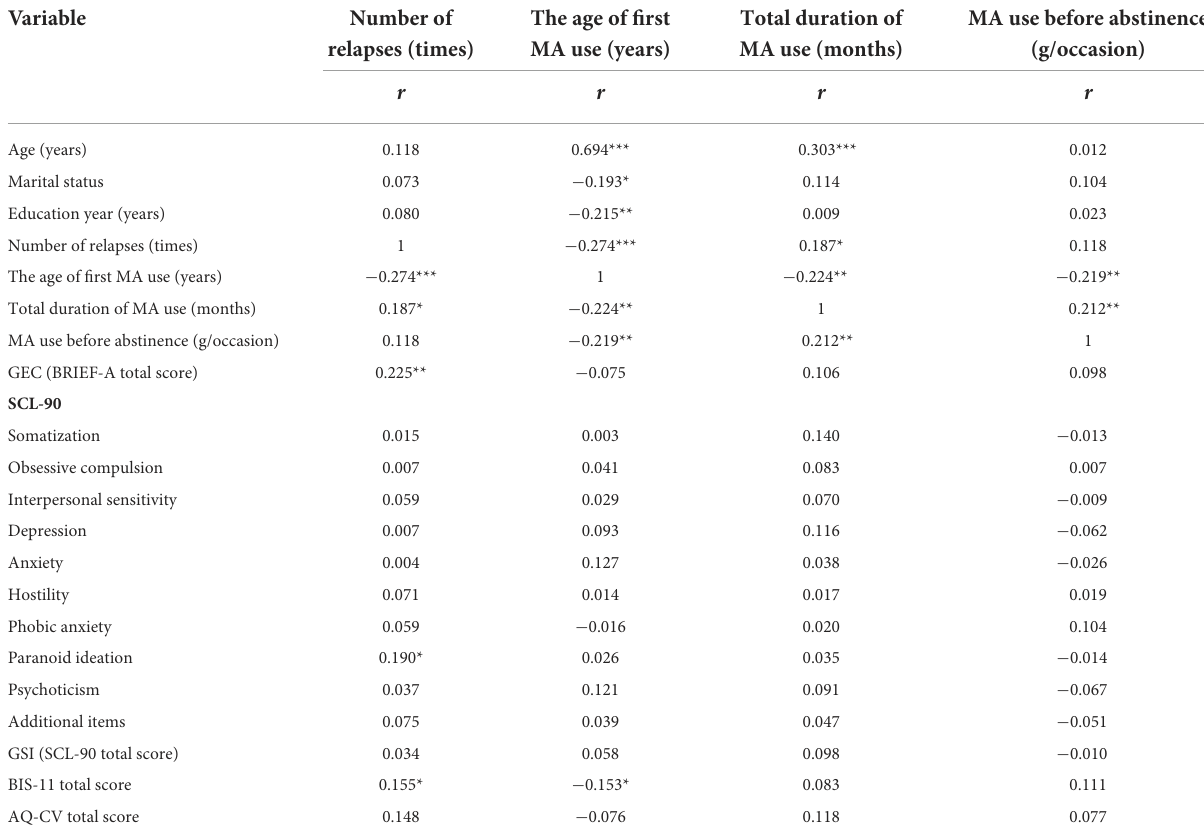
TABLE 3 Relationship between MA use history and psychological characteristics of MUD patients. Variable Number of The age of